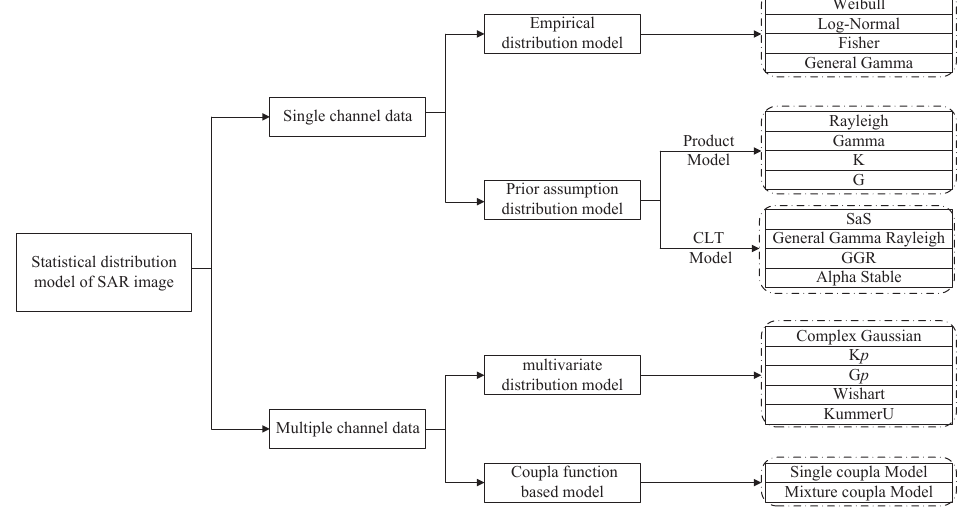
Figure 1. Statistical distribution model of an SAR